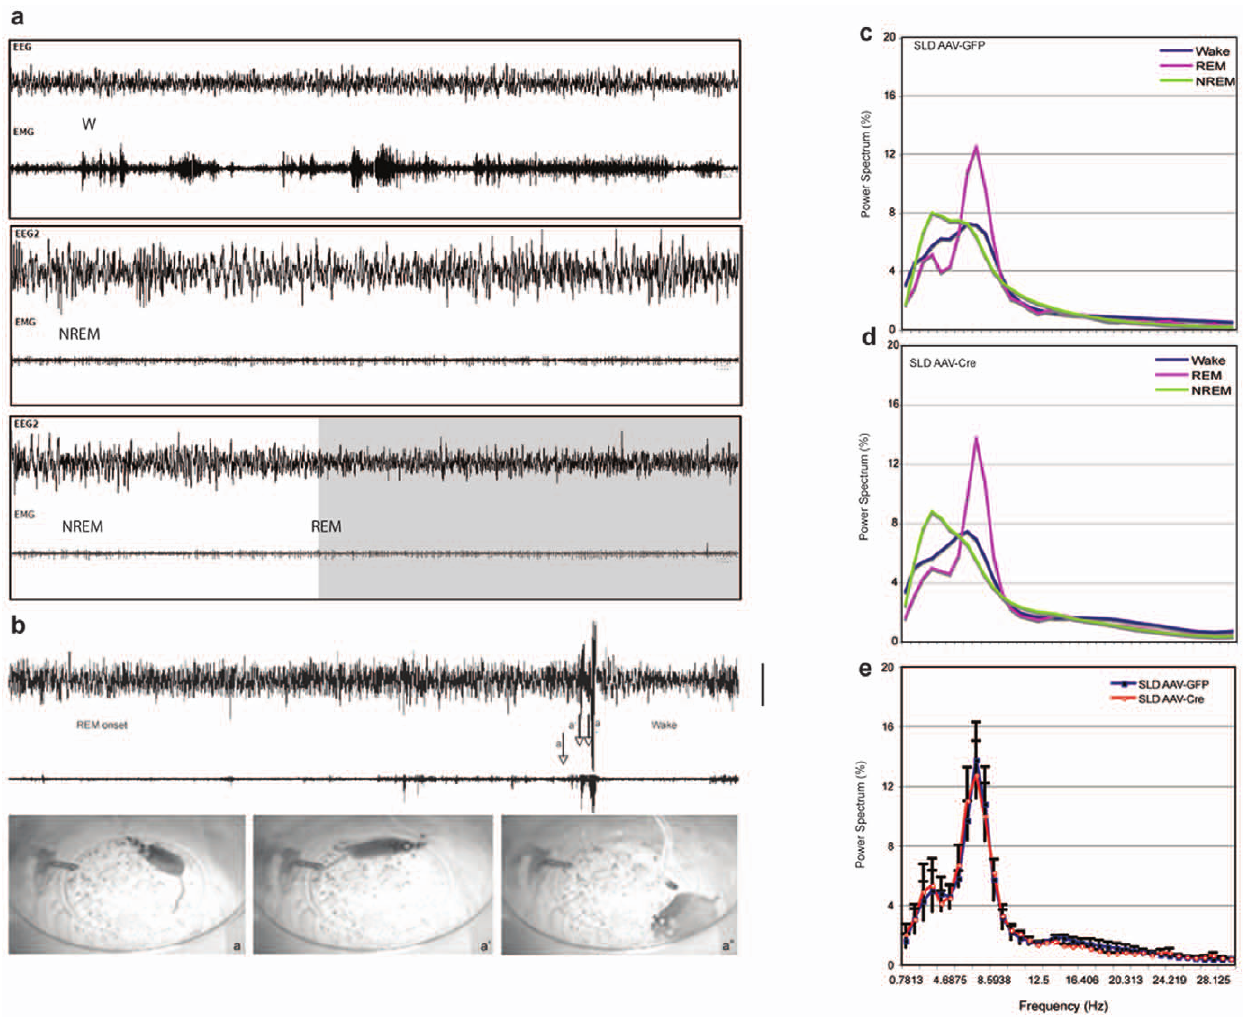
Figure 3. Normal sleep-wake and RBD like behavior episodes. Normal Wake, NREM and REM sleep EEG/EMG segments are shown in panel a. In panel b, a mouse with conditional VGLUT2 knockout in the cLDT-SLD exhibits normal NREM sleep and normal transition into REM sleep. Physiological atonia during REM sleep was observed only for a brief period which was followed by abnormally high muscle tone with kicking, jerking and running during REM episode. Three images within less than two seconds are captured marked by a, a’ and a’’. The tail, posture and animal positions indicate abrupt movement at the end of REM sleep. The entire REM episode lasts about 25 seconds. Notice that the figure shows only the end of REM sleep because animals with RBD show the most dramatic and phasic locomotion (very different from normal waking) at this moment that can be easily visualized by the pictures. The jerking and kicking during REM sleep that are never seen during wakefulness and NREM sleep are hard to visualize by images; however, the supplementary video captures these behaviors very well. Power spectrum of wake, NREM, REM sleep in VGLUT2 knockout is easily distinguishable (c), and power spectrum of REM sleep between control and VGLUT knockout is virtually identical (d). The calibration bar is 200 m